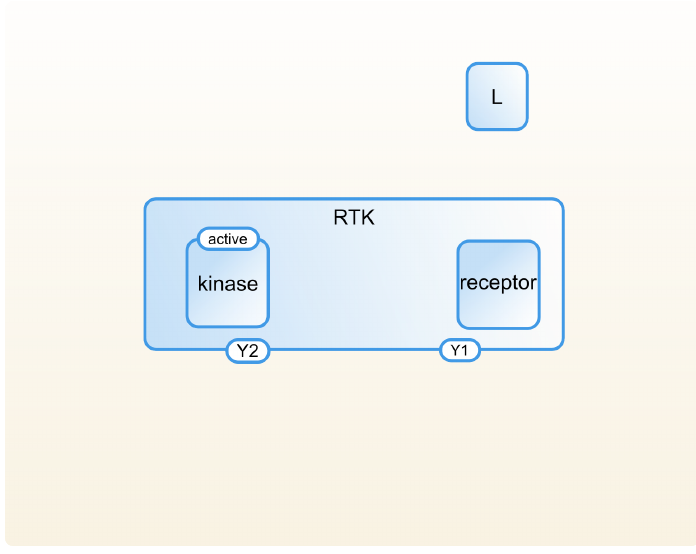
Figure A.1: Receptor tyrosine kinase activation: definition of